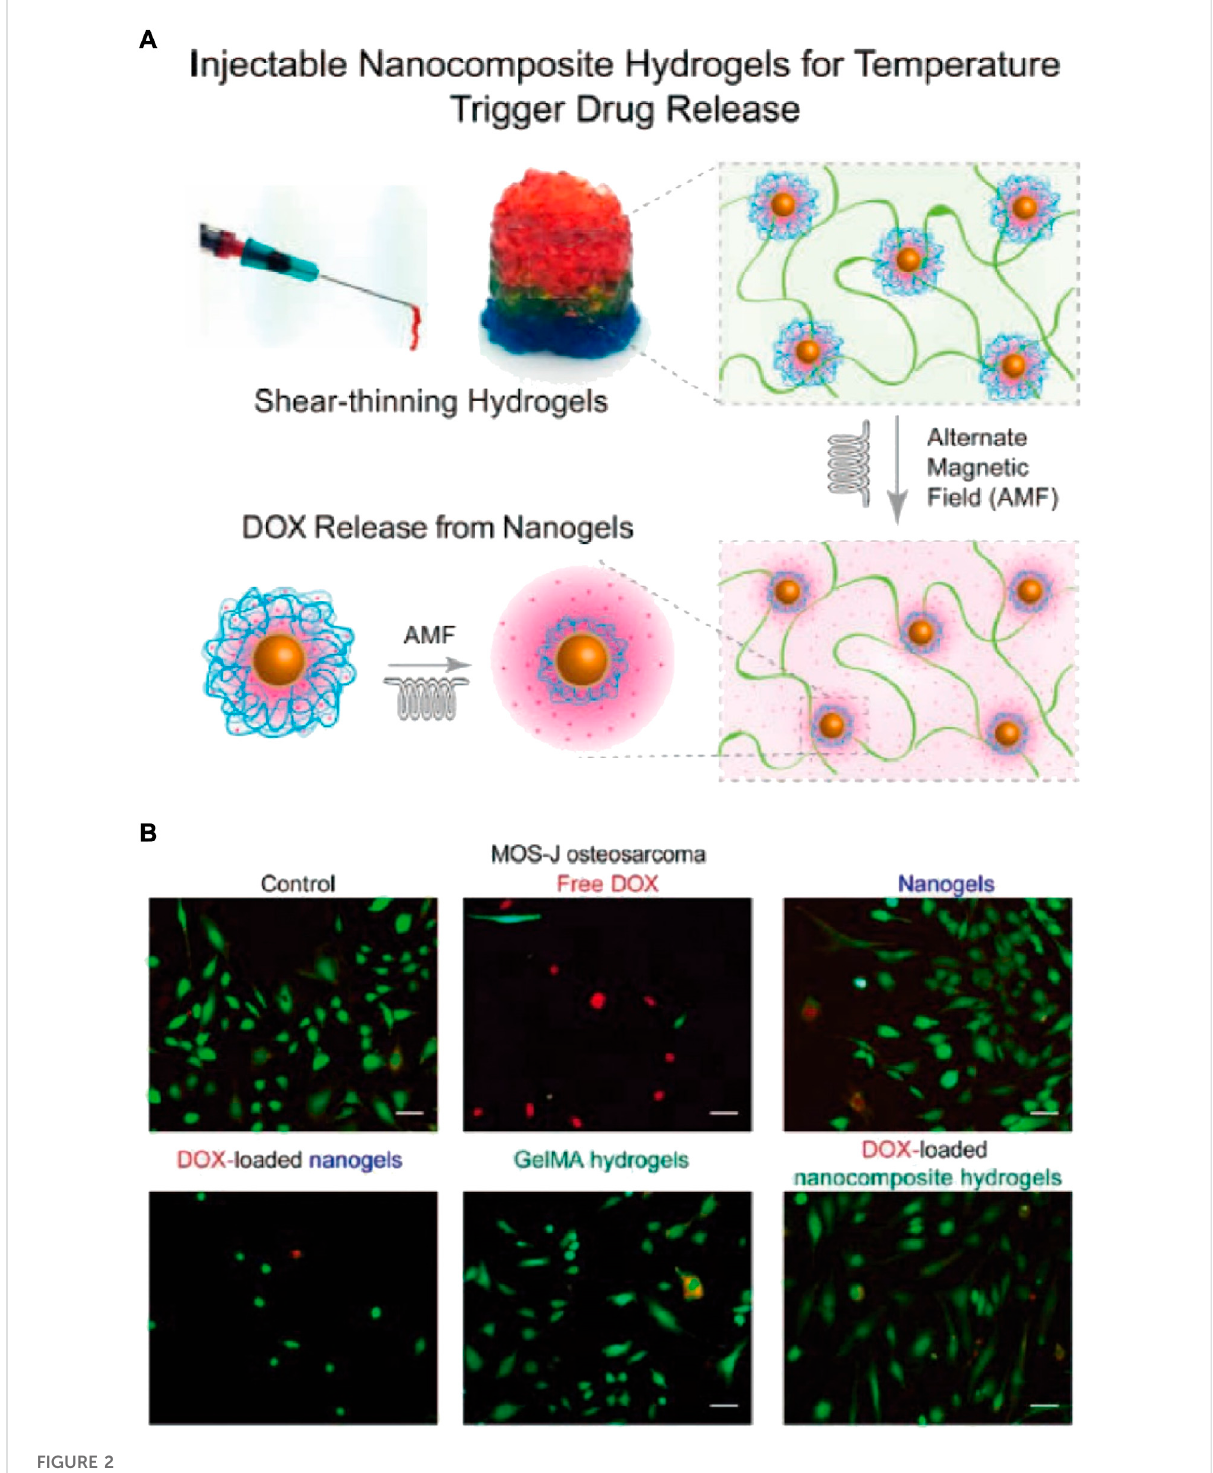
FIGURE 2 (A) Schematic depiction ofnanocompositehydrogels fabricationthat can beinjected for drug release inresponse tostimuli. (B) MOS-Js, live or dead staining indicated more dead cells upon exposure with free DOX than nanogels and nanocomposites loaded DOX (Scale bar 100 μ m).